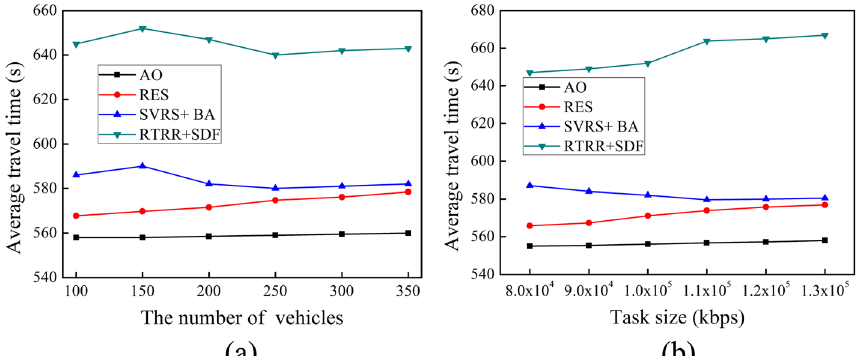
Fig. 4 Impact of travel time. a w.r.t. The number of vehicles b w.r.t. Task size